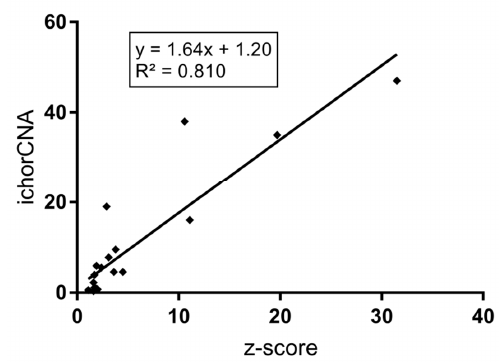
Figure 2. Correlation (R 2 of 0.81) between mFAST-SeqS z-score and ichorCNA.